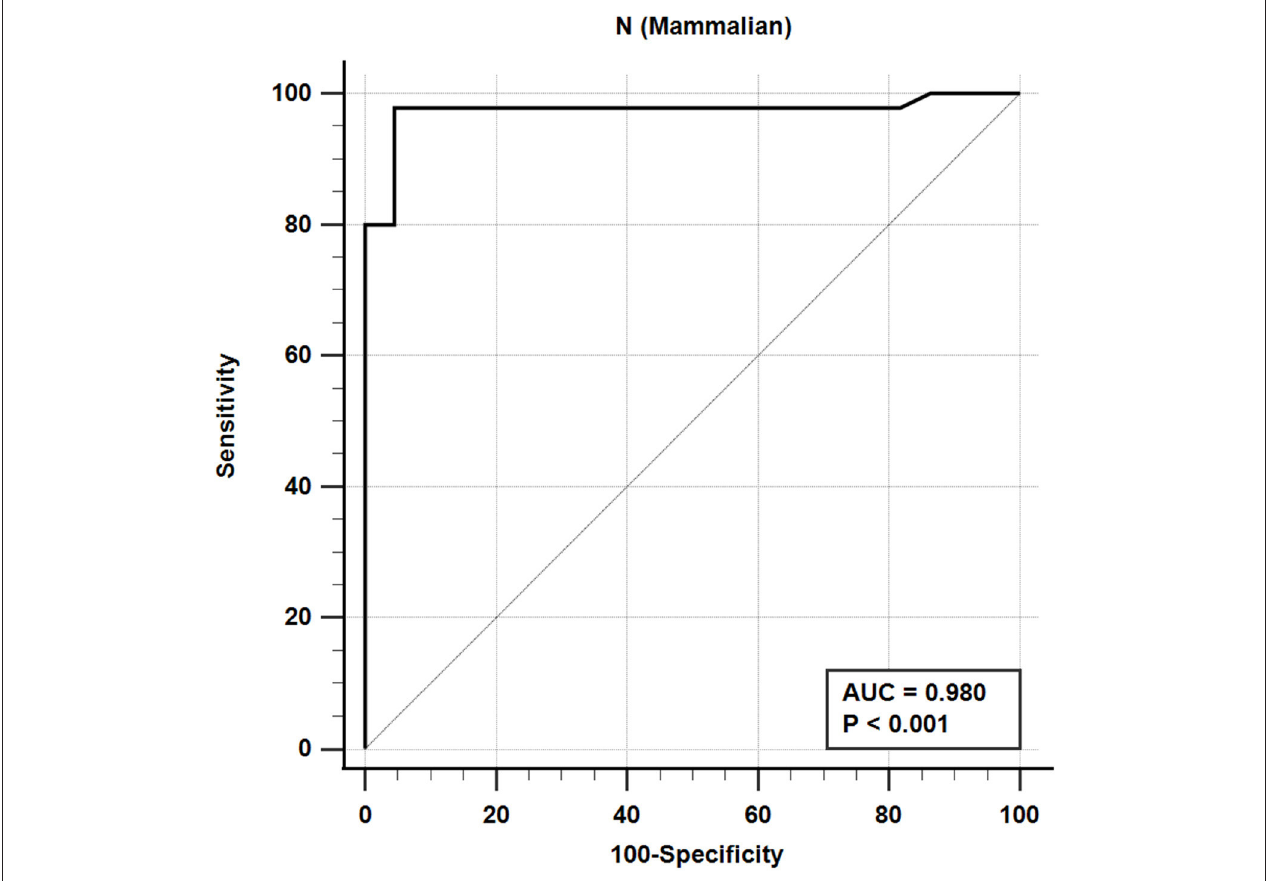
FIGURE 2 | Receiver-operating characteristic (ROC) analysis for the N M protein iELISA. The line represents 95% confidence interval, and the upper left corner is the highest Youden index indicating the best combined sensitivity and specificity of 97.8% and 95.5%, respectively. AUC, area under the curve.